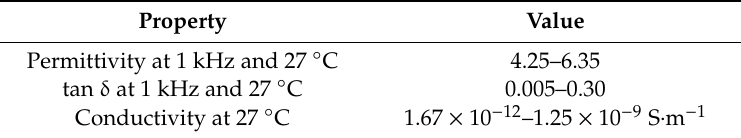
Table 5. Electrical properties of cured epoxy resin (information adapted from